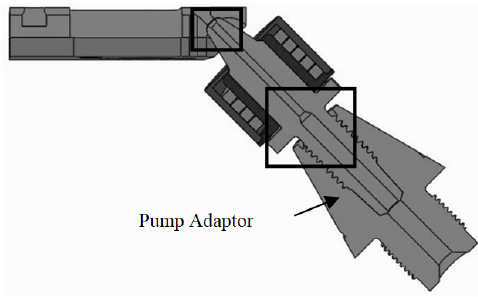
Figure 12. Bottom frame plate interaction with the